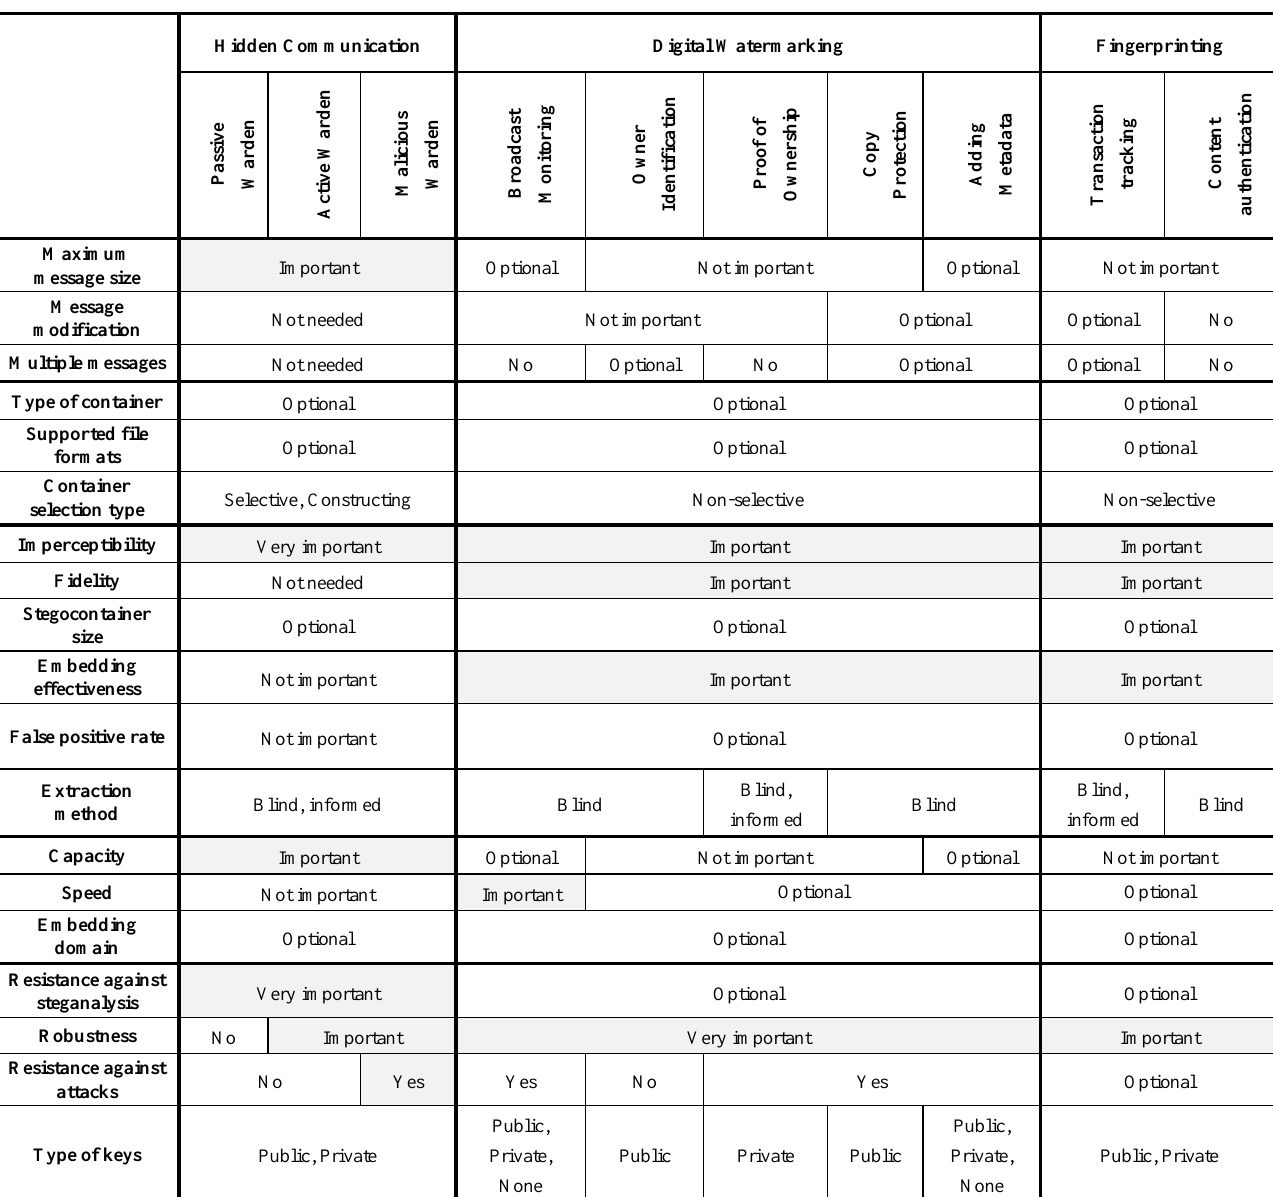
I MPORTANCE OF C RITERIA BY F IELDS OF U SE AND P OSSIBLE V